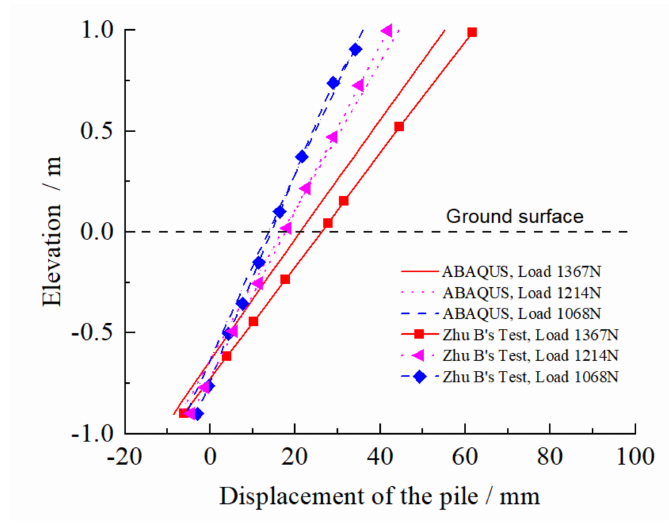
Figure 5. Pile deformation under various loading